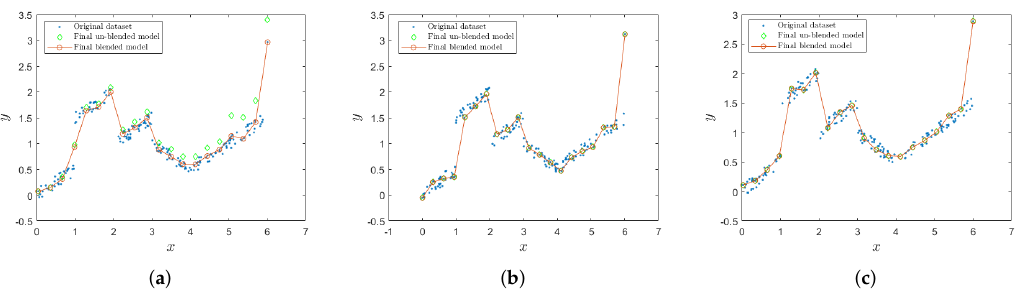
Figure 3. Results of non-isotonic modeling obtained on the Data set 1 with r = 0.1 and: ( a ) c = 0.0001, ( b ) c = 0.00001, ( c ) c = 0.000001.